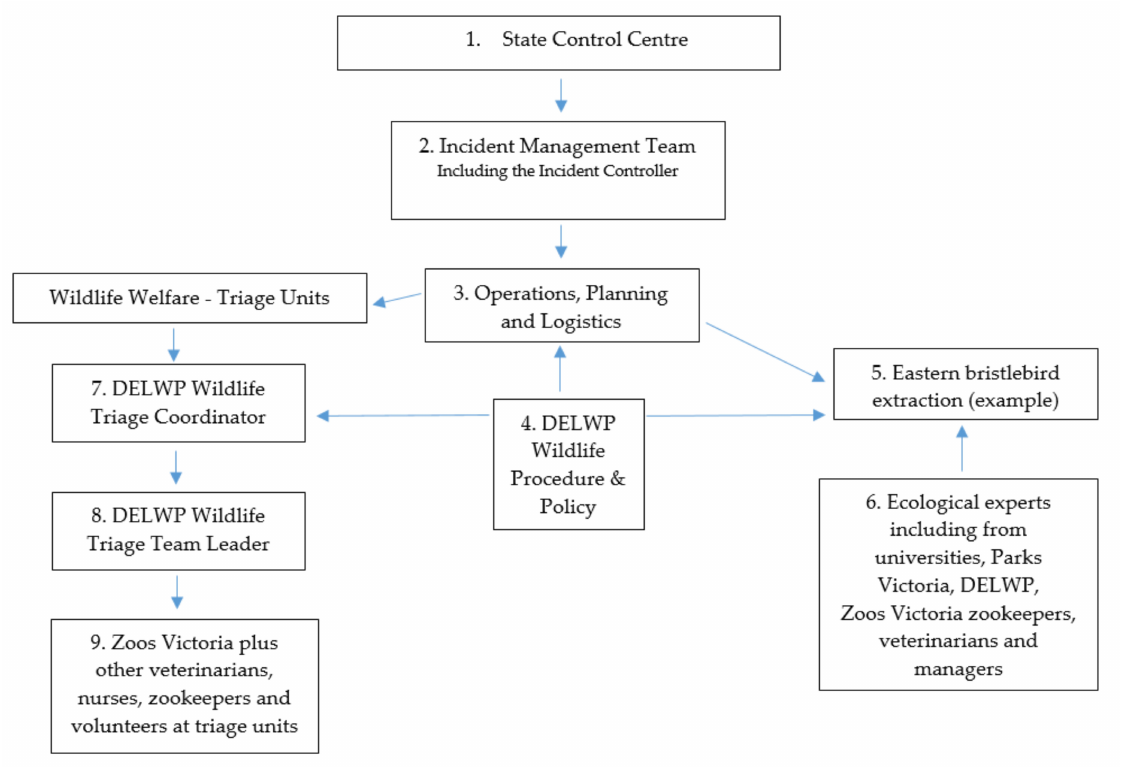
Figure 1. A simplified flow chart of Zoos Victoria’s involvement in the state-led emergency response, including wildlife triage governance and the eastern bristlebird extraction as examples. Numbers in the figure boxes correspond to the numbered explanations below. The structure includes: ( 1 ) State Control Centre (SCC), which oversees all emergencies